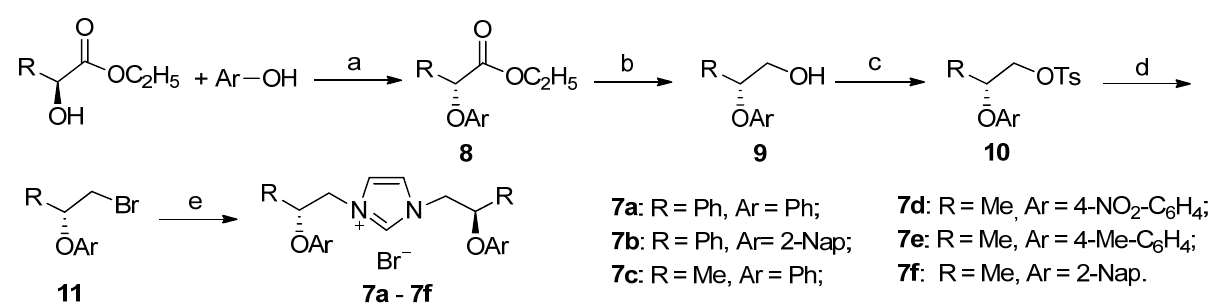
Scheme 1. Synthesis of the NHC precursor imidazolium salts 7a – f